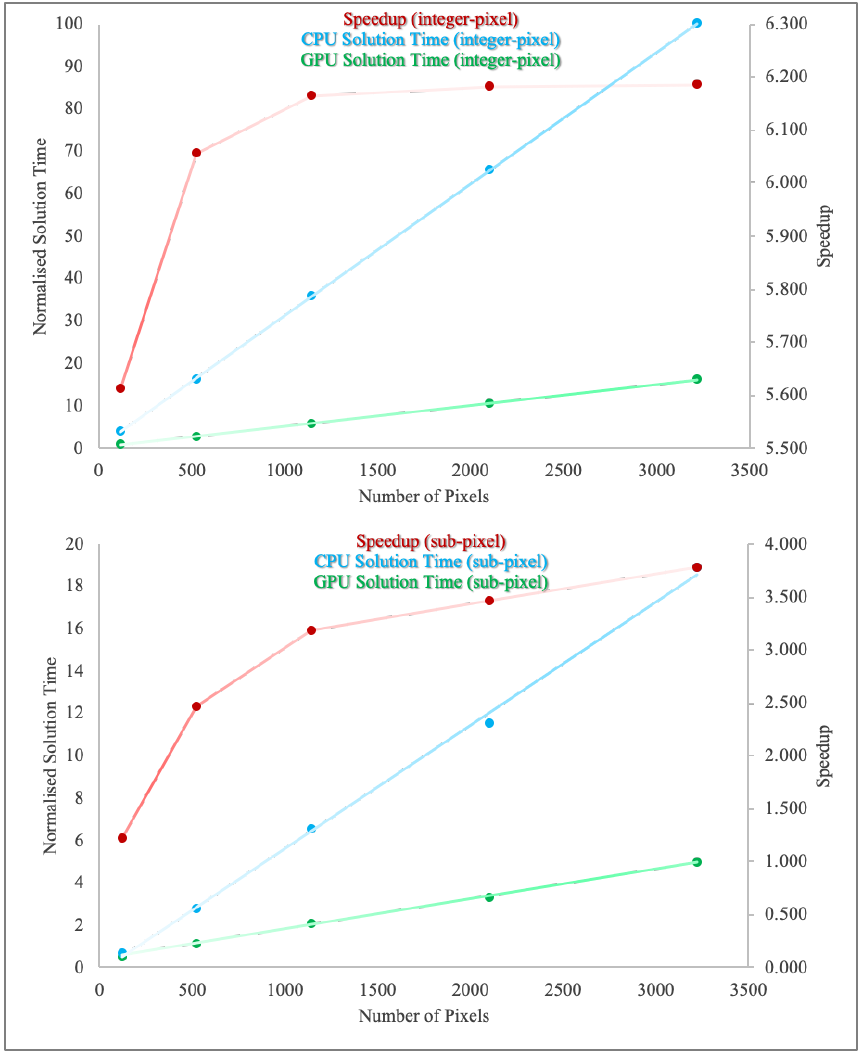
Figure 8. Results of the benchmark tests in terms of normalised solution times of serial CPU and parallel GPU computing.